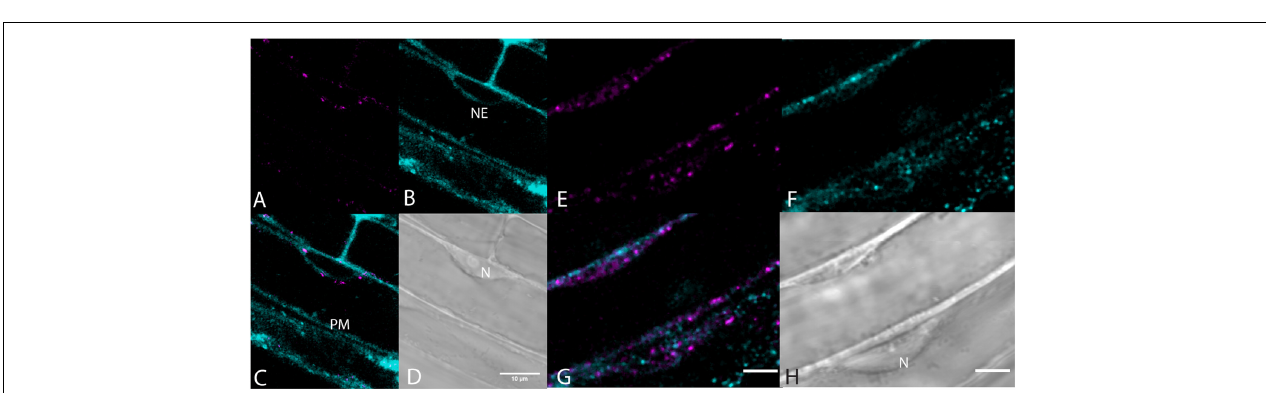
FIGURE 7 | Lack of endosome labels, VTI12-mCherry, and RabF2a-mCherry, with BCh of the elongating root cells. (A–D) Structures labeled after 30 min of incubation in BCh (cyan) in plants expressing the early endosome/ trans- Golgi marker, VTI12-mCherry (magenta). (A) Fluorescence of VTI12-mCherry organelles. (B) Fluorescence of BCh labels the NE and the PM. (C) Merged image of (A and B) , where magenta endosomes are outside the NE and in the cytoplasm. (D) DIC micrograph showing the nucleus (N). Scale bar = 10 µ m. (E–H) Structures labeled with BCh (cyan) after 30 min in plants expressing RabF2a-mCherry (magenta). (E) Late endosomes labeled with RabF2a-mCherry. (F) BCh (cyan) labels the PM and non-endosomal punctae in the cytosol. (G) Merged image of (E and F) showing magenta endosomes that do not colocalize with the non-endosomal cyan punctae. (H) DIC image showing a glancing optical section of the nucleus (N). Scale bars in (G) and (H) = 5 µ